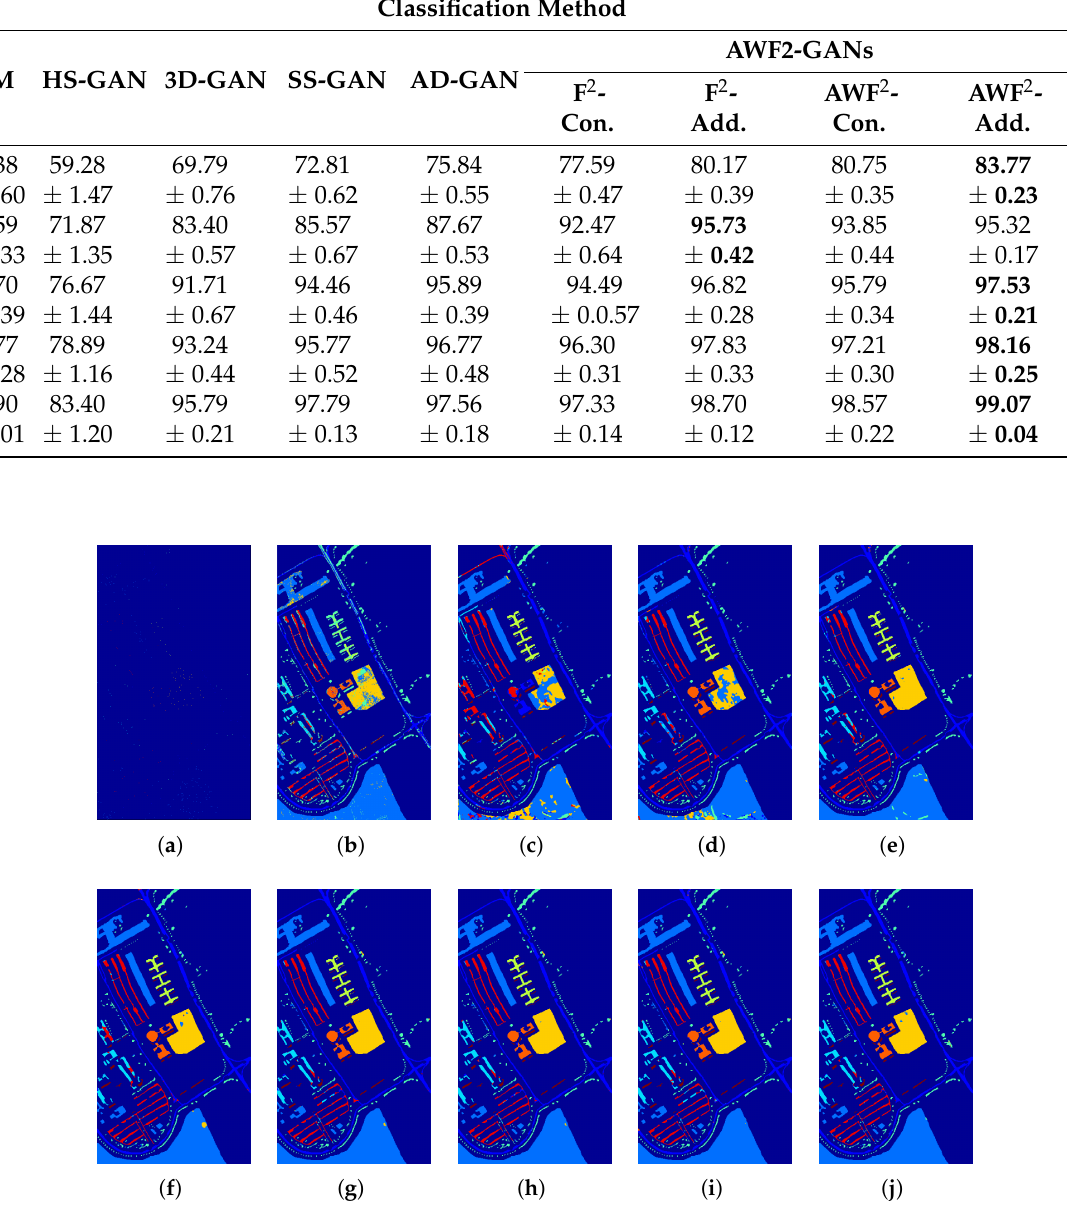
Figure 9. Classification maps for the UP dataset with 350 labeled training samples: ( a )